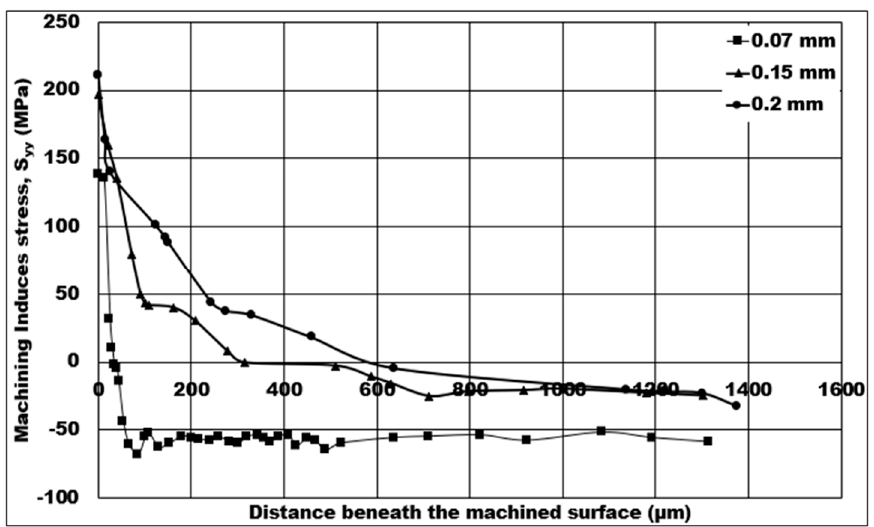
Figure 9. Numerical machining induced stress distribution under the influence of uncut chip thick- ness (10% volume fraction, cutting speed = 50 m/min, dry cutting).